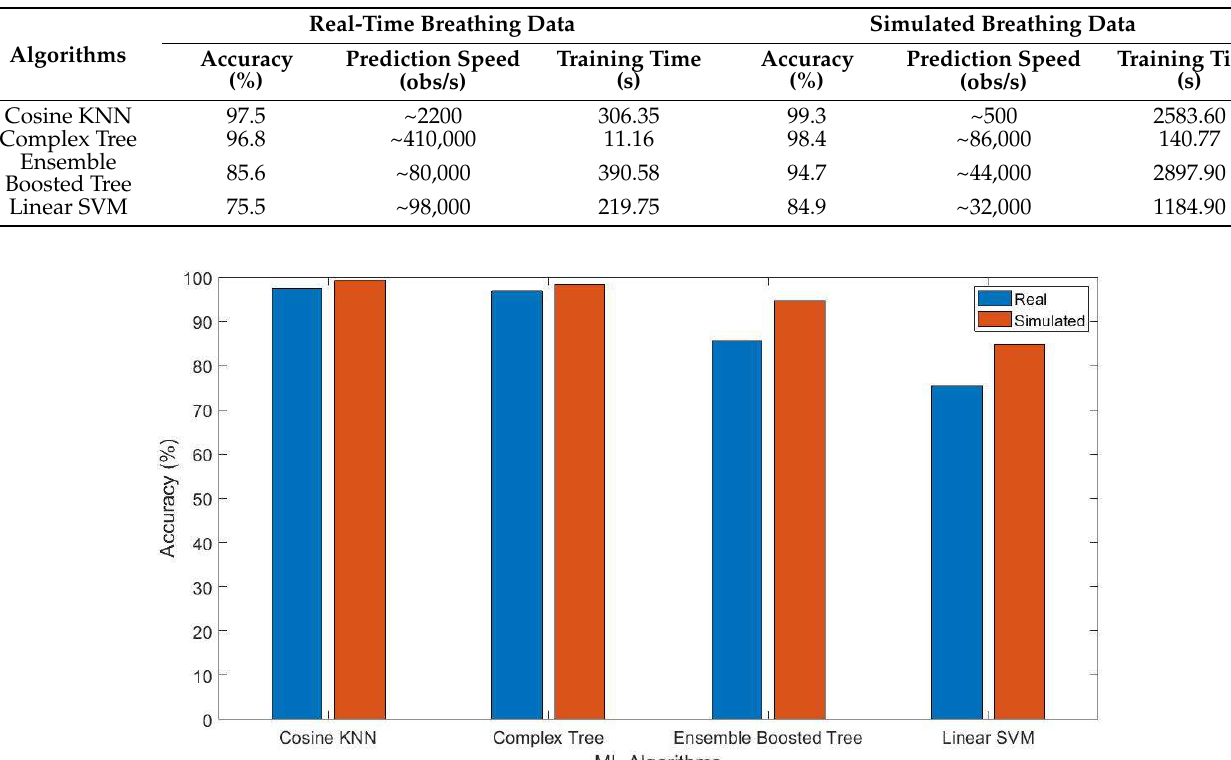
Figure 8. Comparison of the algorithms’ accuracy.